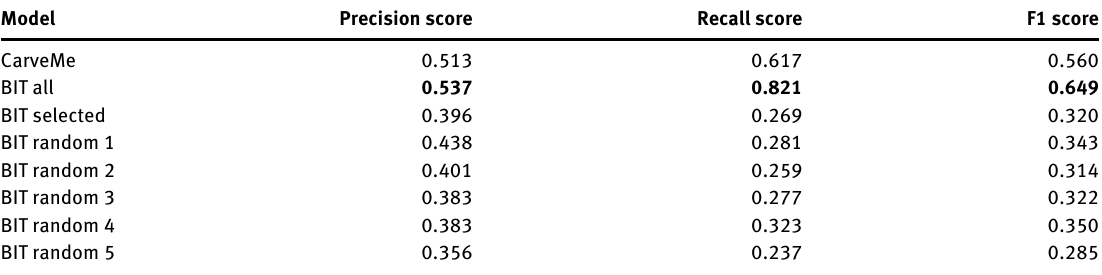
Table 1: Comparison of the evaluation metrics between draft models generated with CarveMe and with BIT for M. tuberculosis . Model Precision score Recall